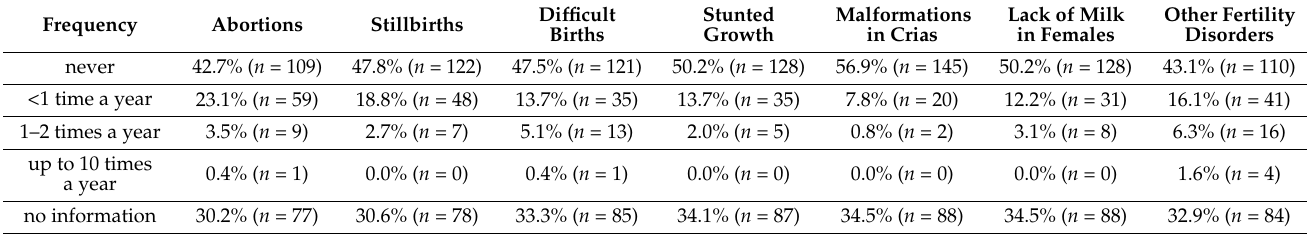
Table 8. Observation of the owners: frequency of diseases or symptoms affecting reproduction ( n = 255).